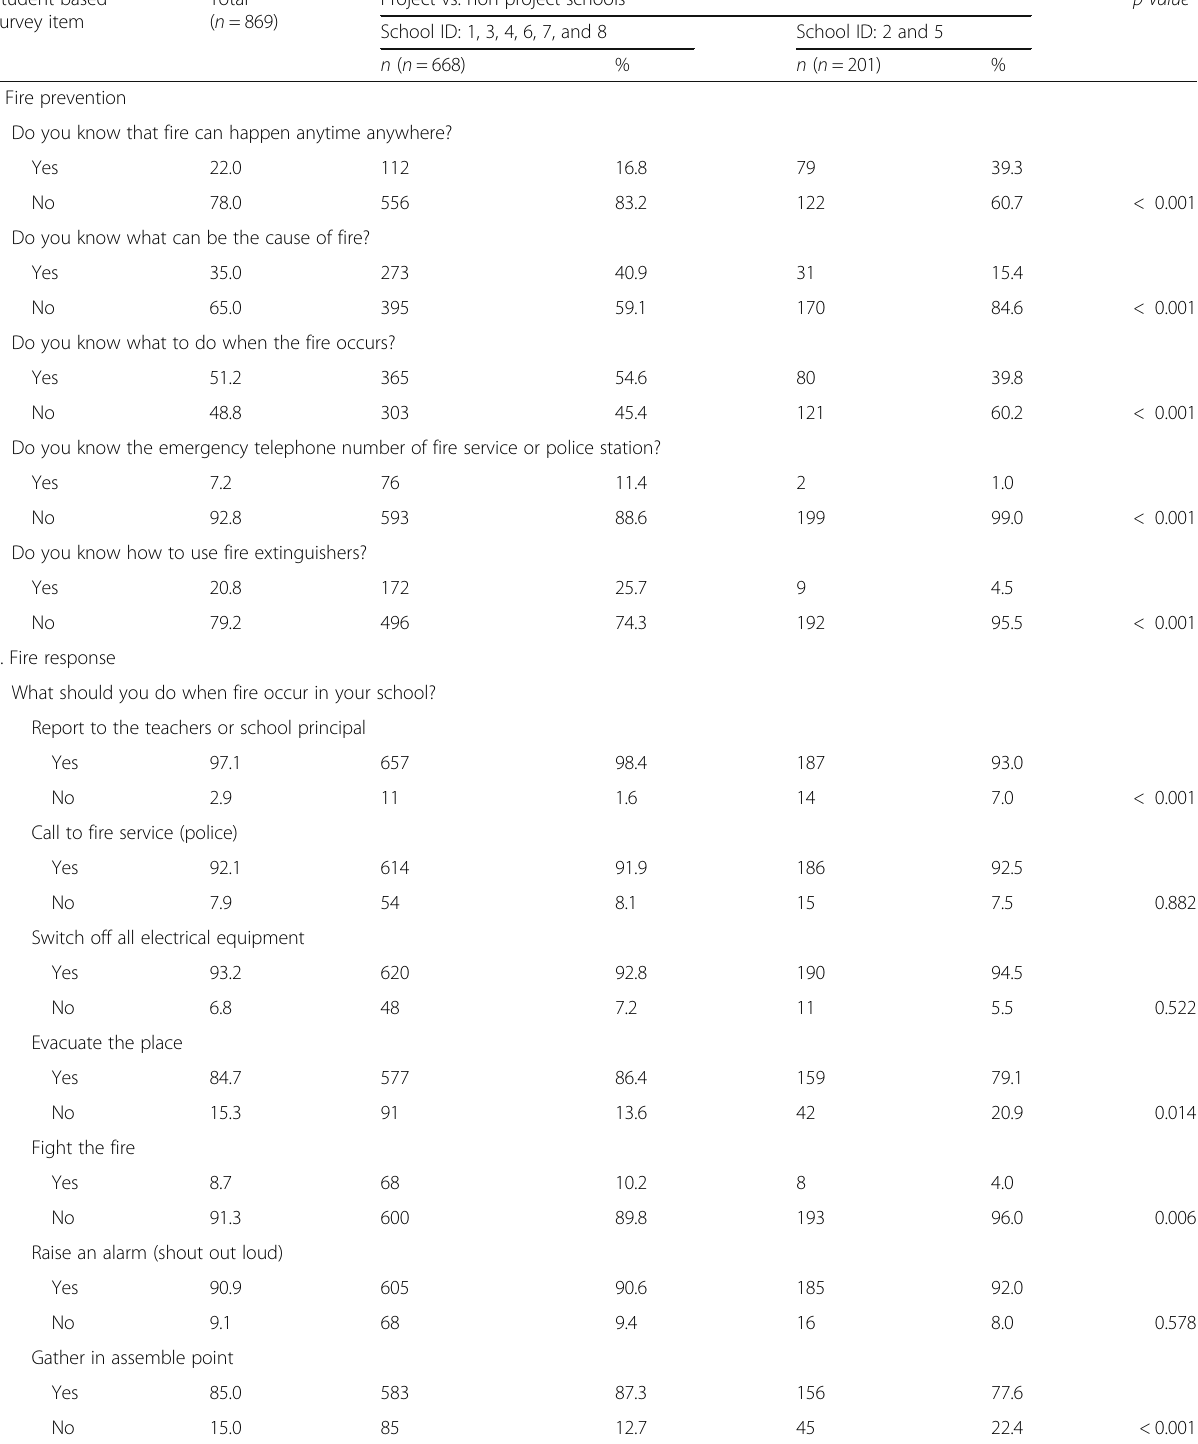
Table 4 Student knowledge on fire prevention and response between project and non-project schools Student-based survey